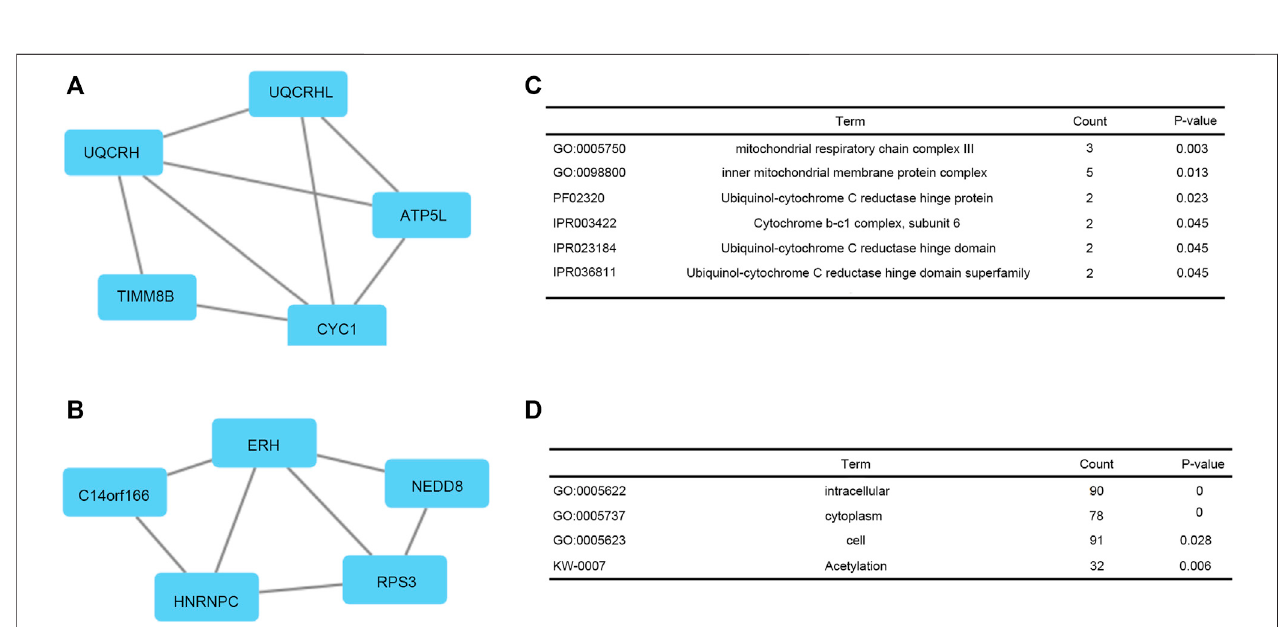
FIGURE 7 | Top two modules from the PPI network. (A, C) PPI network and enrichment analysis of module 1. (B, D) PPI network and enrichment analysis of module 2.